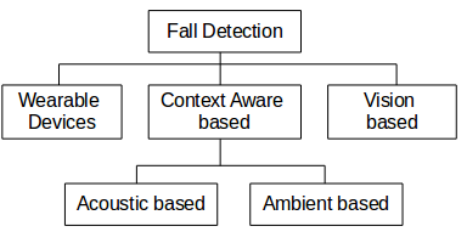
Figure 1. Classification of fall detection